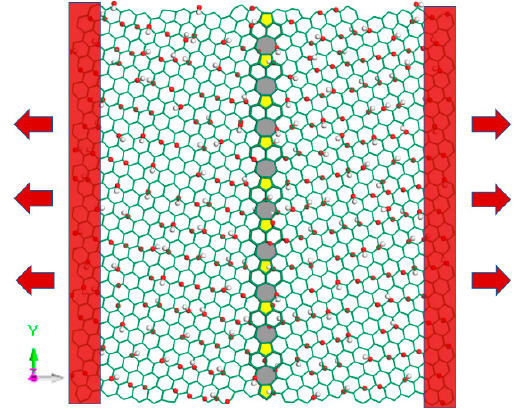
Figure 3. Tensile diagram of polycrystalline graphene oxide.